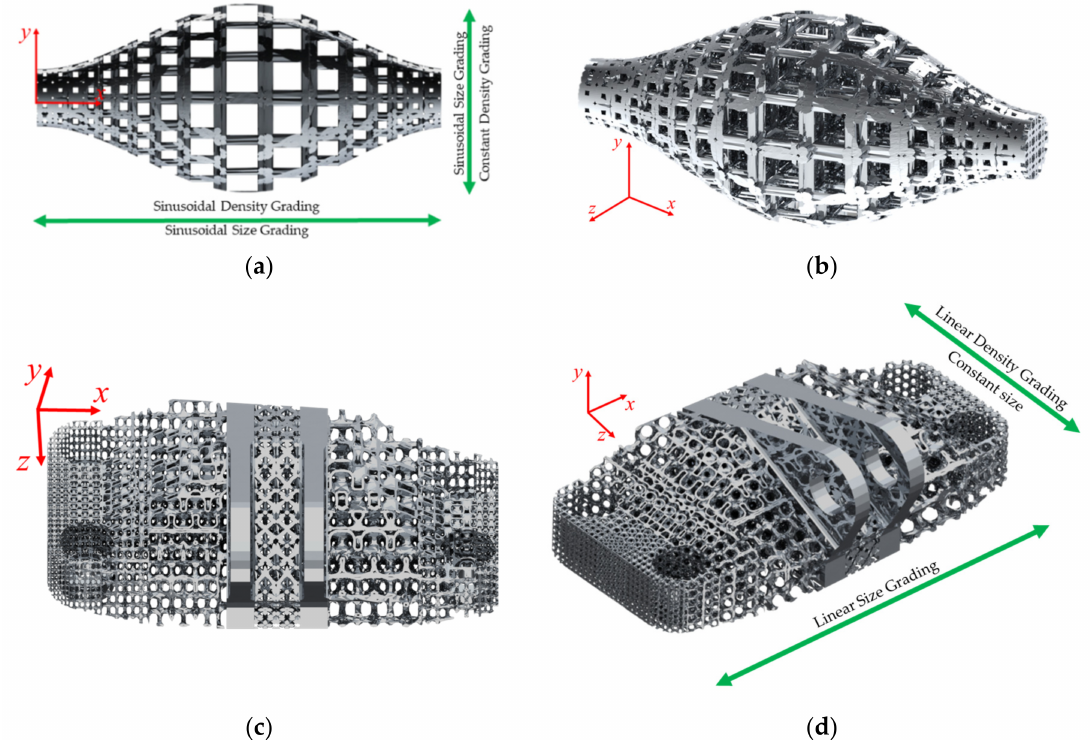
Figure 5. Dual graded lattice structure: ( a ) Front view and ( b ) isometric view of a sinusoidal-based revolved parts filled with a cubic unit cell and ( c ) top-down view and ( d ) isometric view of GE bracket filled with IWP Schoen unit